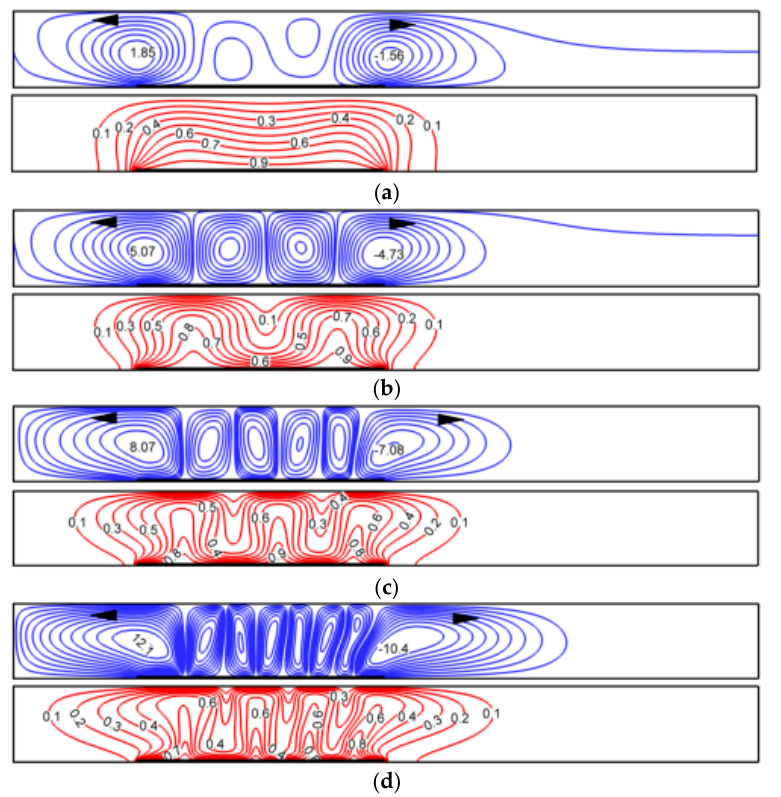
Figure 3. Streamlines (above) and isotherms (below) profiles for different Ra numbers and Pe = 1, ( c = 0.33), ( a ) Ra = 100, ( b ) Ra = 250, ( c ) Ra = 500, ( d ) Ra = 1000